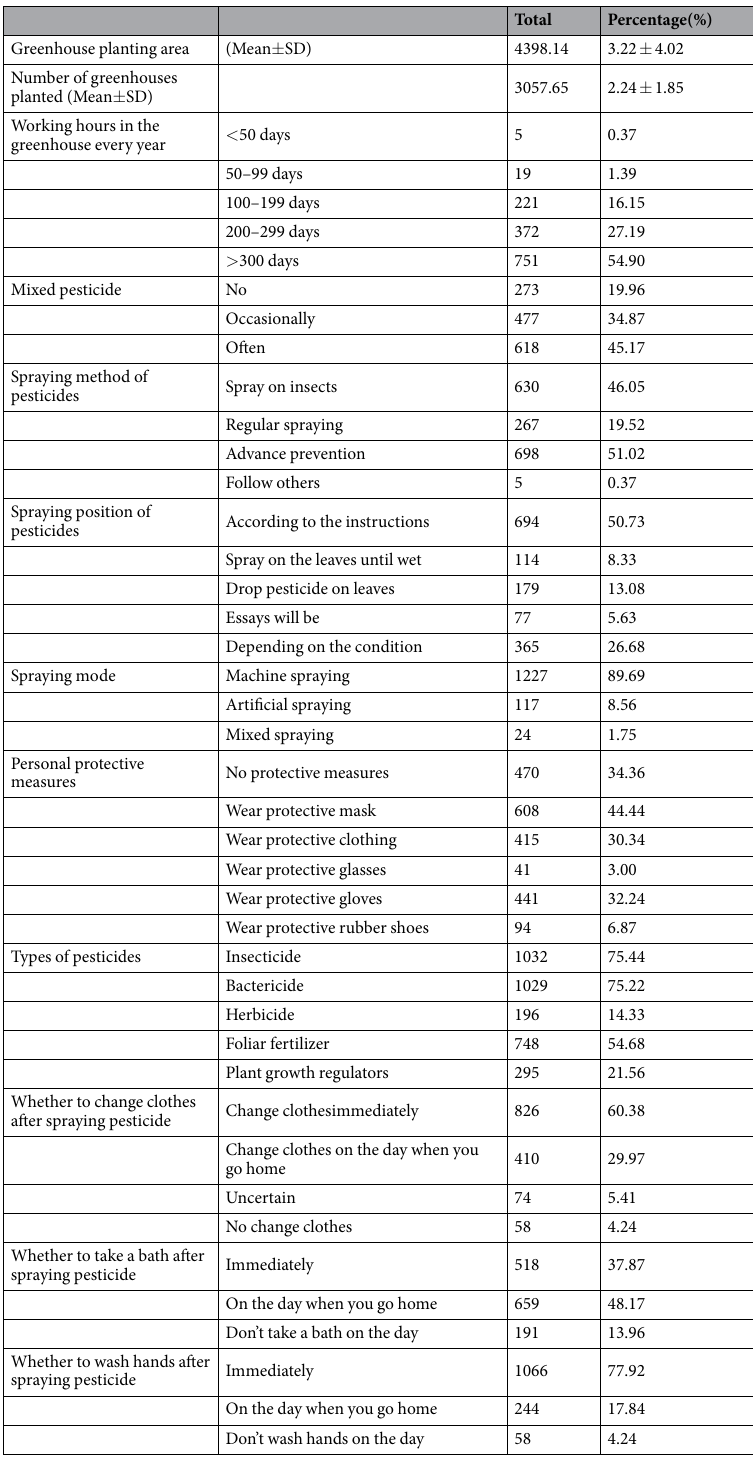
Table 1. Descriptive analysis of working environment and pesticide use in